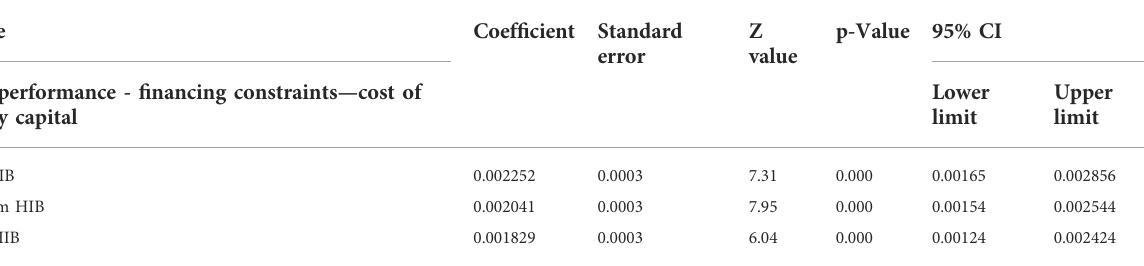
TABLE 4 Conditional effect regression of stock liquidity.